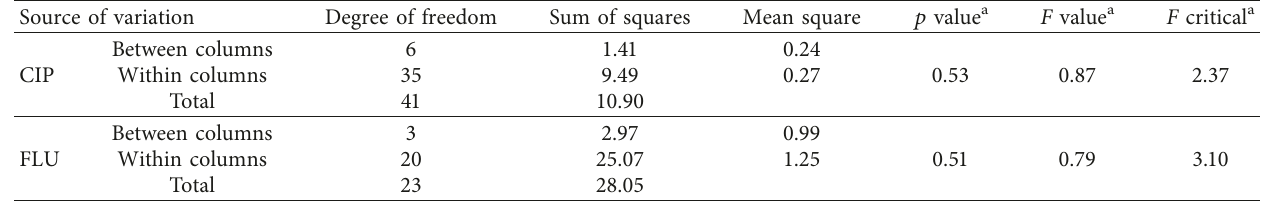
Table 5: Results of one-way ANOVA for comparison of the proposed and the official methods [6] for determination of (CIP) and FLU in Otovel ® otic solution. Source of variation